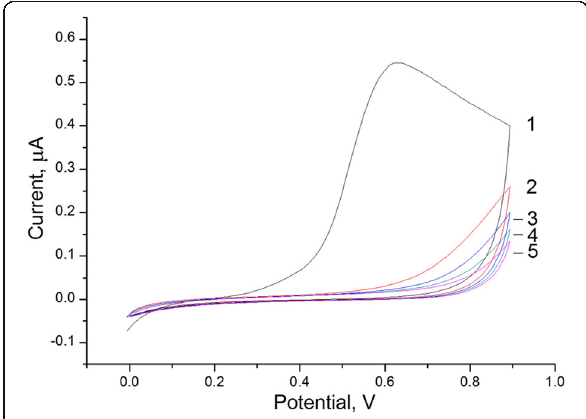
Fig. 1 Cyclic voltammograms obtained at phenylenediamine electropolymerization on transducer surface